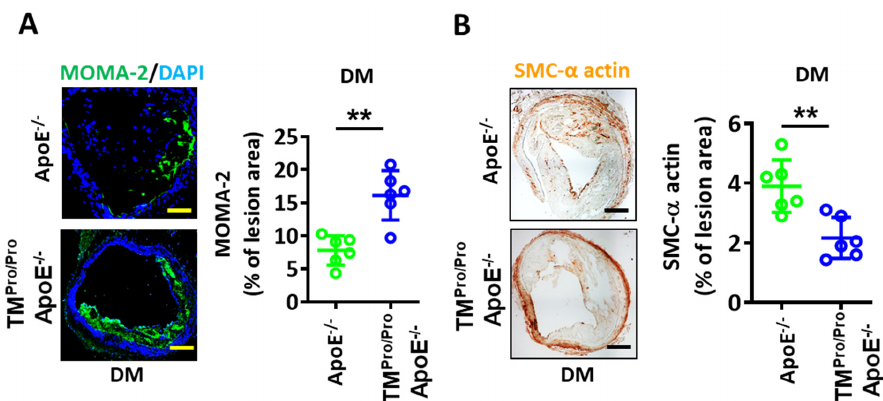
Figure 4. More macrophages and proinflammatory cytokines and fewer smooth muscle cells in hyperglycemic TM Pro/Pro ApoE -/- versus hyperglycemic ApoE -/- mice. ( A ): Representative images showing immunofluorescence staining of macrophages (left panel, MOMA-2, green; DAPI nuclear counterstain, blue) and dot-plot summarizing data (right panel). ( B ): Representative immunohistochemically stained images showing smooth muscle cells (left panel, α -actin, positive cells detected by HRP-DAB reaction, brown) within lesions and dot-plot summarizing data (right panel). Each dot represents data obtained from one mouse specimen (n = 6, each group); ** p < 0.01, Student’s t -Test.